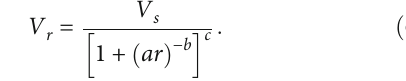
e ff ect of Figure 11 that the surface satis fi es the Rational2D